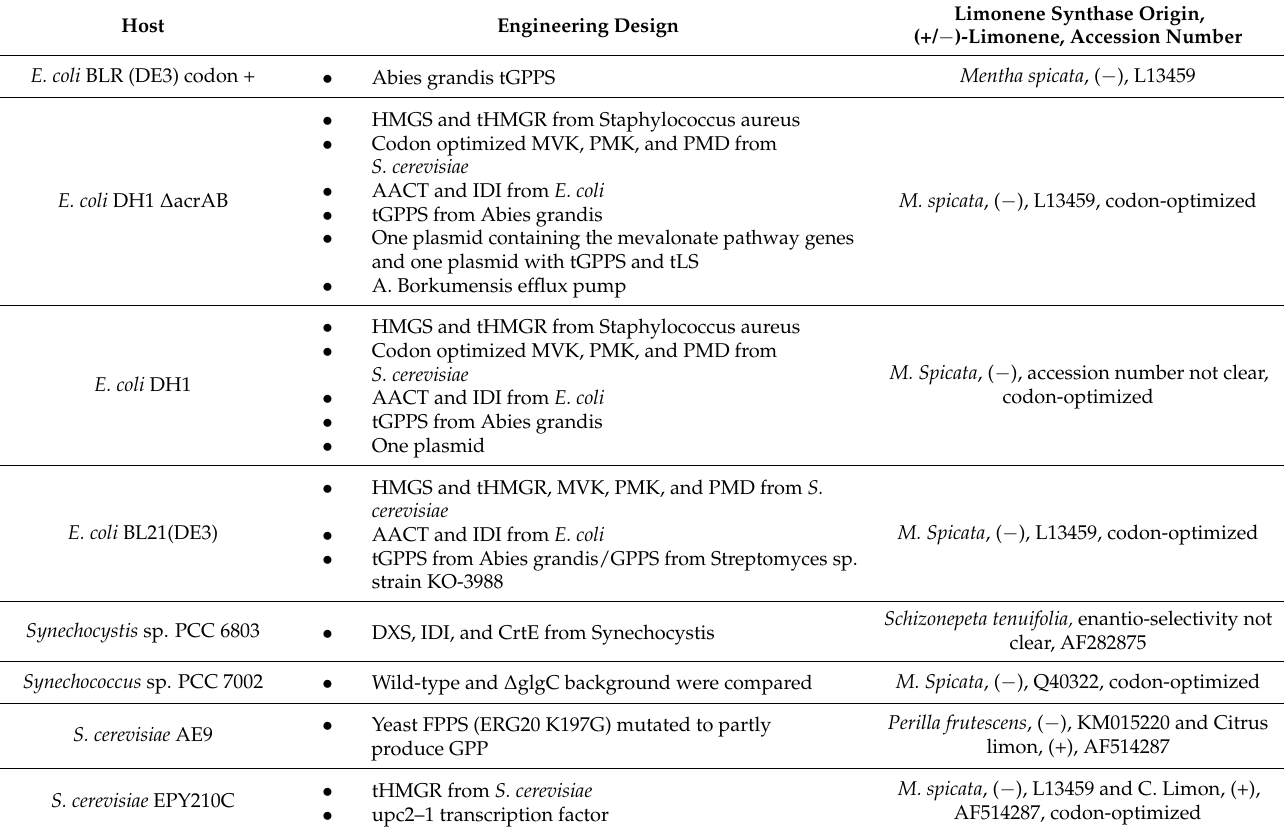
Table 10. Microbial-based synthetic routes for polylimonene through microbial mediated synthesis processes [93]. Host Engineering Design